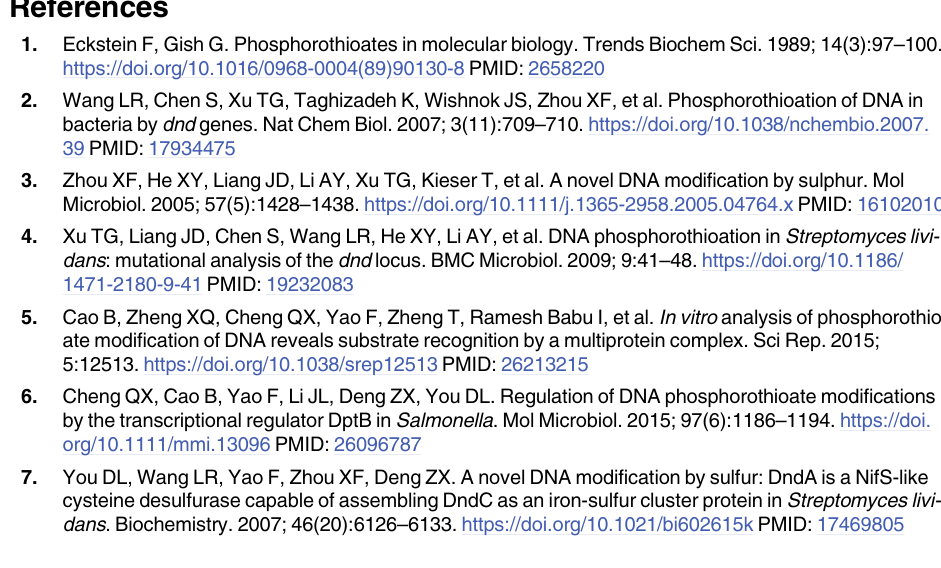
S7 Table. Analysis of consensus sequences in E . coli B7A. S8 Table. DNA primers and probes used in PT-IC-ddPCR. S9 Table. 8 loci of the genome of E . coli B7A quantified PT modification frequency. Eight G AAC/G TTC loci on the genome of E . coli B7A were randomly selected to test the phos- ps ps the modification frequency obtained by